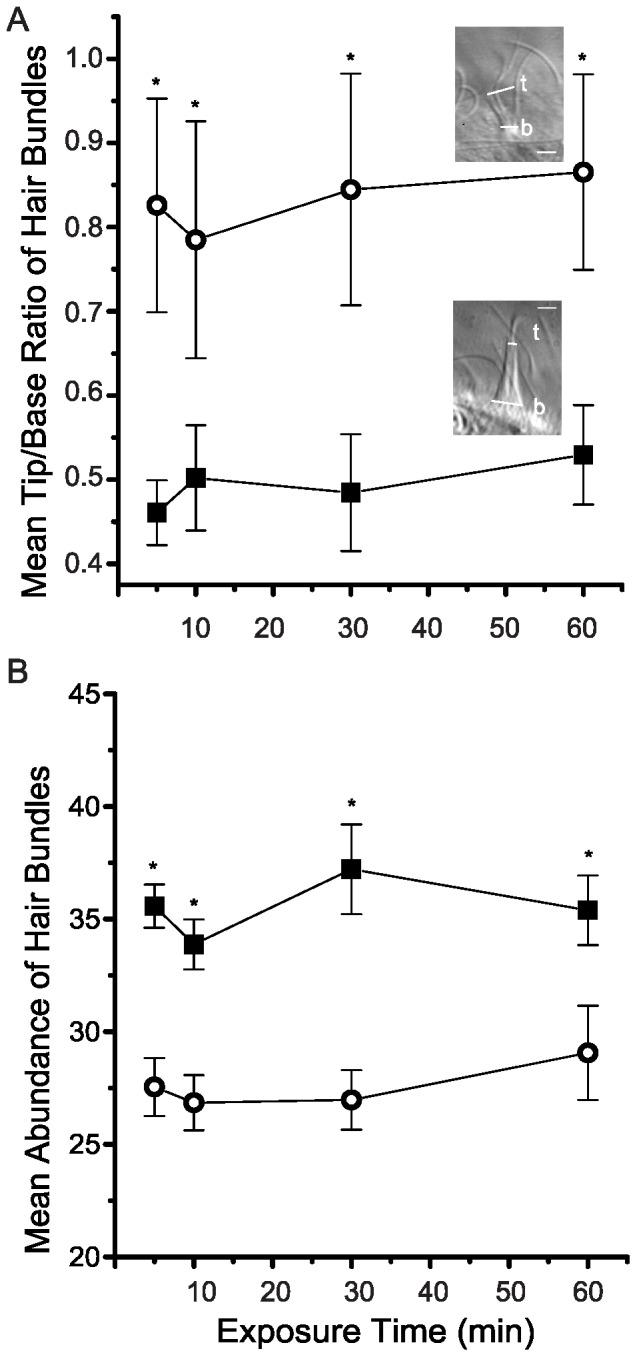
Effects of CDH23 antibodies on morphology and abundance of hair bundles.Morphology was assayed by measuring diameter of hair bundles at their bases (b) and tips (t) and then determining the tip/base ratio for each hair bundle. Hair bundle abundance was measured by the number of hair bundles at the tip of tentacles in a field of view (∼260 µm of tentacle length). (A) The mean tip/base ratio (±SEM, n = 8) is plotted for hair bundles imaged in untreated, healthy controls (closed squares) and in animals exposed to 0.1 nM CDH23 antibodies (open circles). Insets show images of an extremely splayed hair bundle (top) and a normal hair bundle (bottom). Scale bar  = 2 µm. (B) The mean abundance of hair bundles (±SEM, n = 3) on the tentacle epithelium is plotted for untreated, healthy controls (closed squares) and for animals exposed to 0.1 nM CDH23 antibody (open circles). Asterisks indicate significant differences based on time-adjusted pairwise comparisons between controls and experimentals (p<0.05).